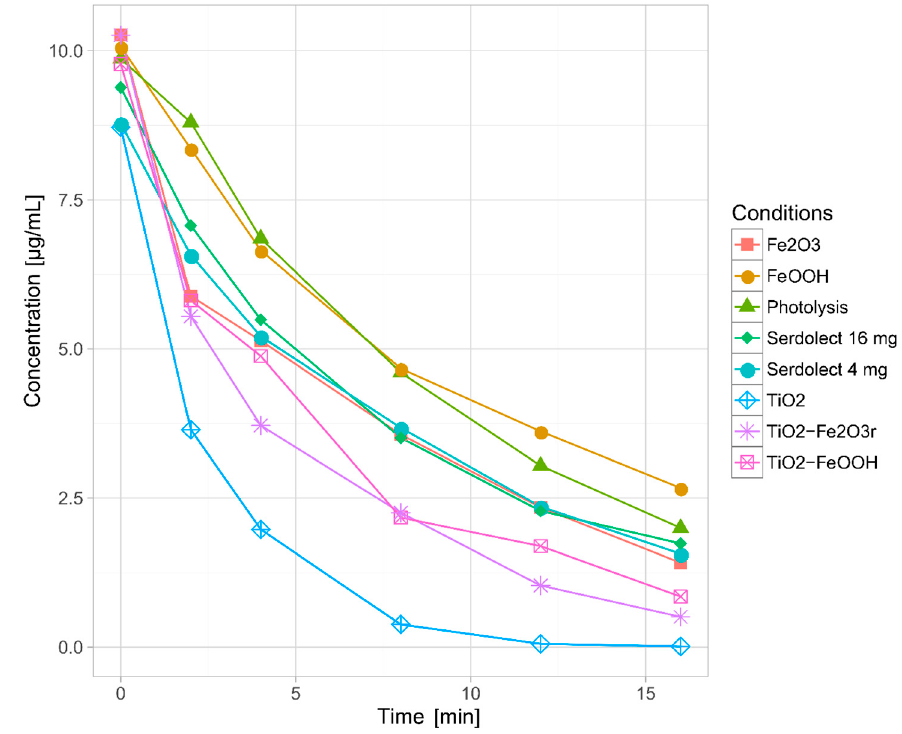
Figure 1. Kinetics of sertindole photodecomposition. Table 2. Summary of sertindole degradation kinetics parameters.